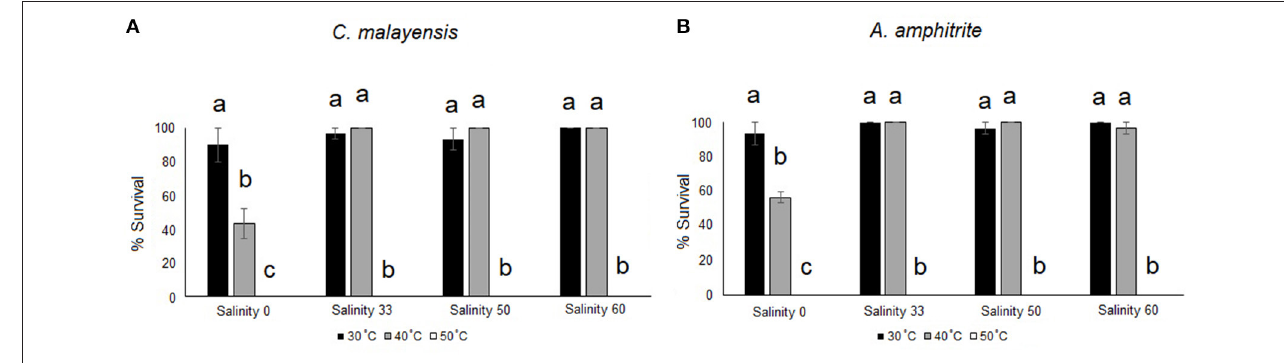
FIGURE 7 | Percentage of barnacles, namely, (A) C. malayensis and (B) A. amphitrite (mean ± SE), that survived under different temperature and salinity treatments. Different small letters = significant difference between temperature within each salinity treatment. Note survival of barnacles is 0 in 50 ◦ C. TABLE 6 | Two-way ANOVA on the effects of Temperature and Salinity on the percentage of survival of two species of barnacles. Source of